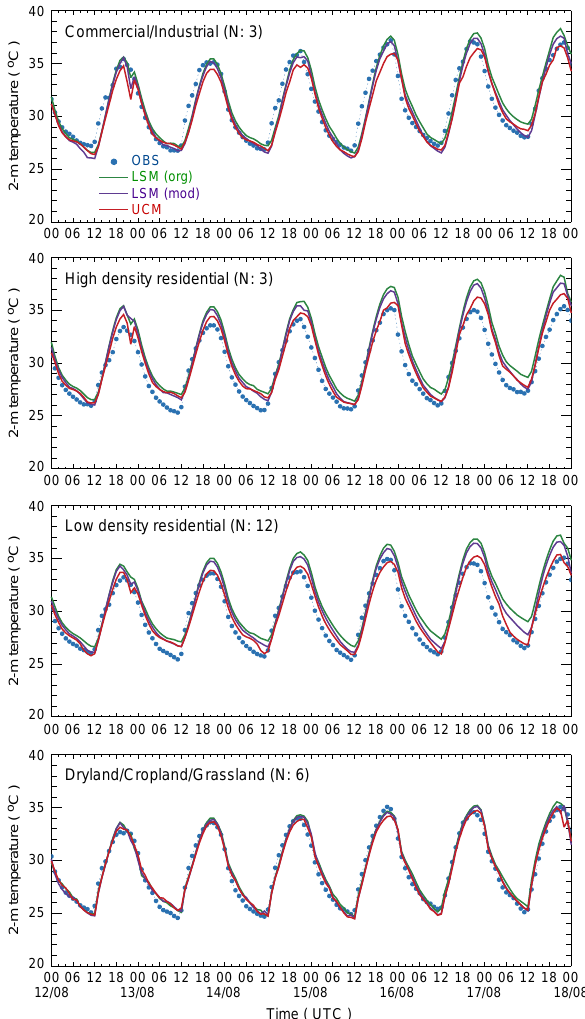
Fig. 4. Diurnal variations of the 2-m air temperatures from 24 sur- face sites and three simulations conducted with different urban sur- face parameterizations. The temperatures were averaged in terms of land-use type. N denotes the number of surface sites for each land-use type.